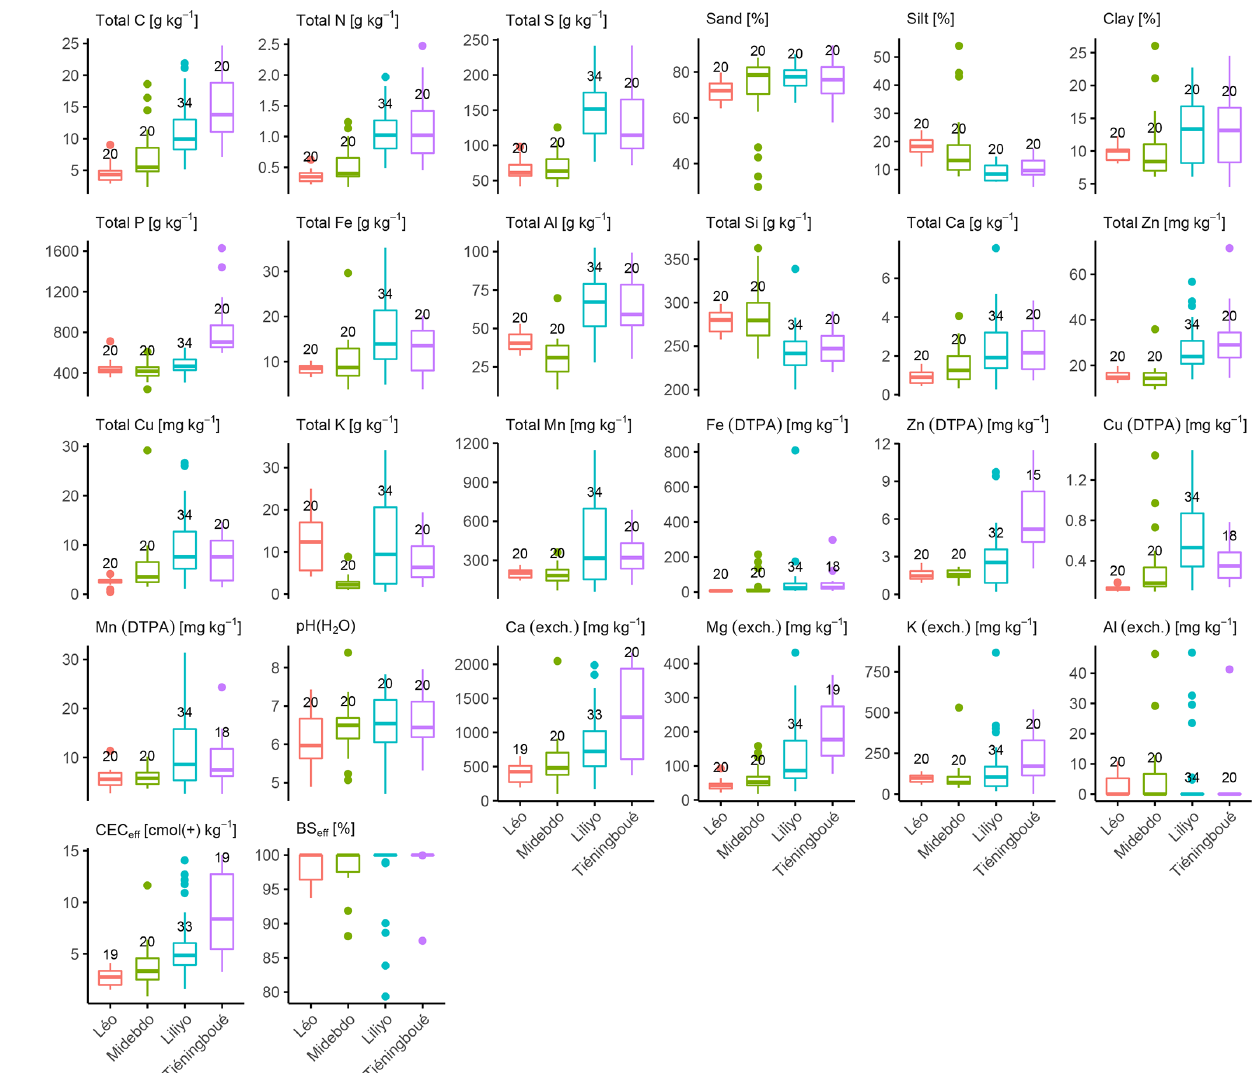
Figure 1. Reference measurements of soil chemical properties. Léo and Midebdo are two yam-growing landscapes in Burkina Faso, and Liliyo and Tiéningboué are in Côte d’Ivoire. The chemically analyzed soils ( n = 94) originated from 20 yam fields per landscape and 14 additional soils from the Liliyo region were provided by the World Agroforestry Center (ICRAF). C is carbon, N is nitrogen, P is phosphorus, Fe is iron, Al is aluminum, Si is silicon, Ca is calcium, Zn is zinc, Cu is copper, K is potassium, and Mn is manganese. Bioavailable micronutrients were measured by the diethylenetriaminepentaacetic acid (DTPA) extraction method. Ca(exch.), Mg(exch.), K(exch.), and Al(exch.) signify exchangeable elements determined with BaCl 2 extraction. CEC eff is the effective cation exchange capacity, and BS eff is the effective base saturation. The number of soils analyzed for each individual property is indicated above the 75%